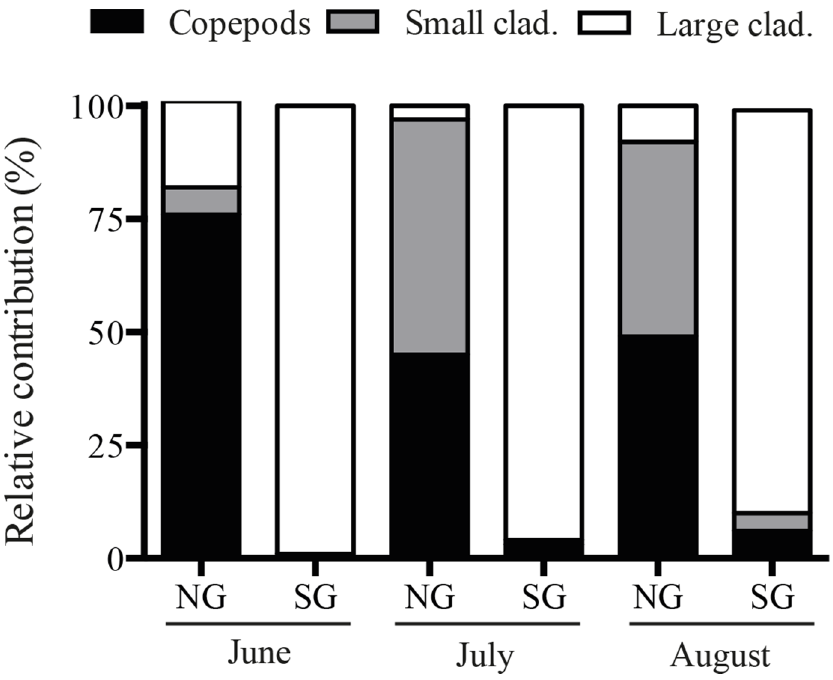
Figure 1. Relative community composition (%), on a biomass basis, of copepods, small cladocerans and large cladocerans in the different grazer communities in June, July and August, respectively. NG=naturally occurring grazer community, SG=standardized ( Daphnia dominated) grazer community.